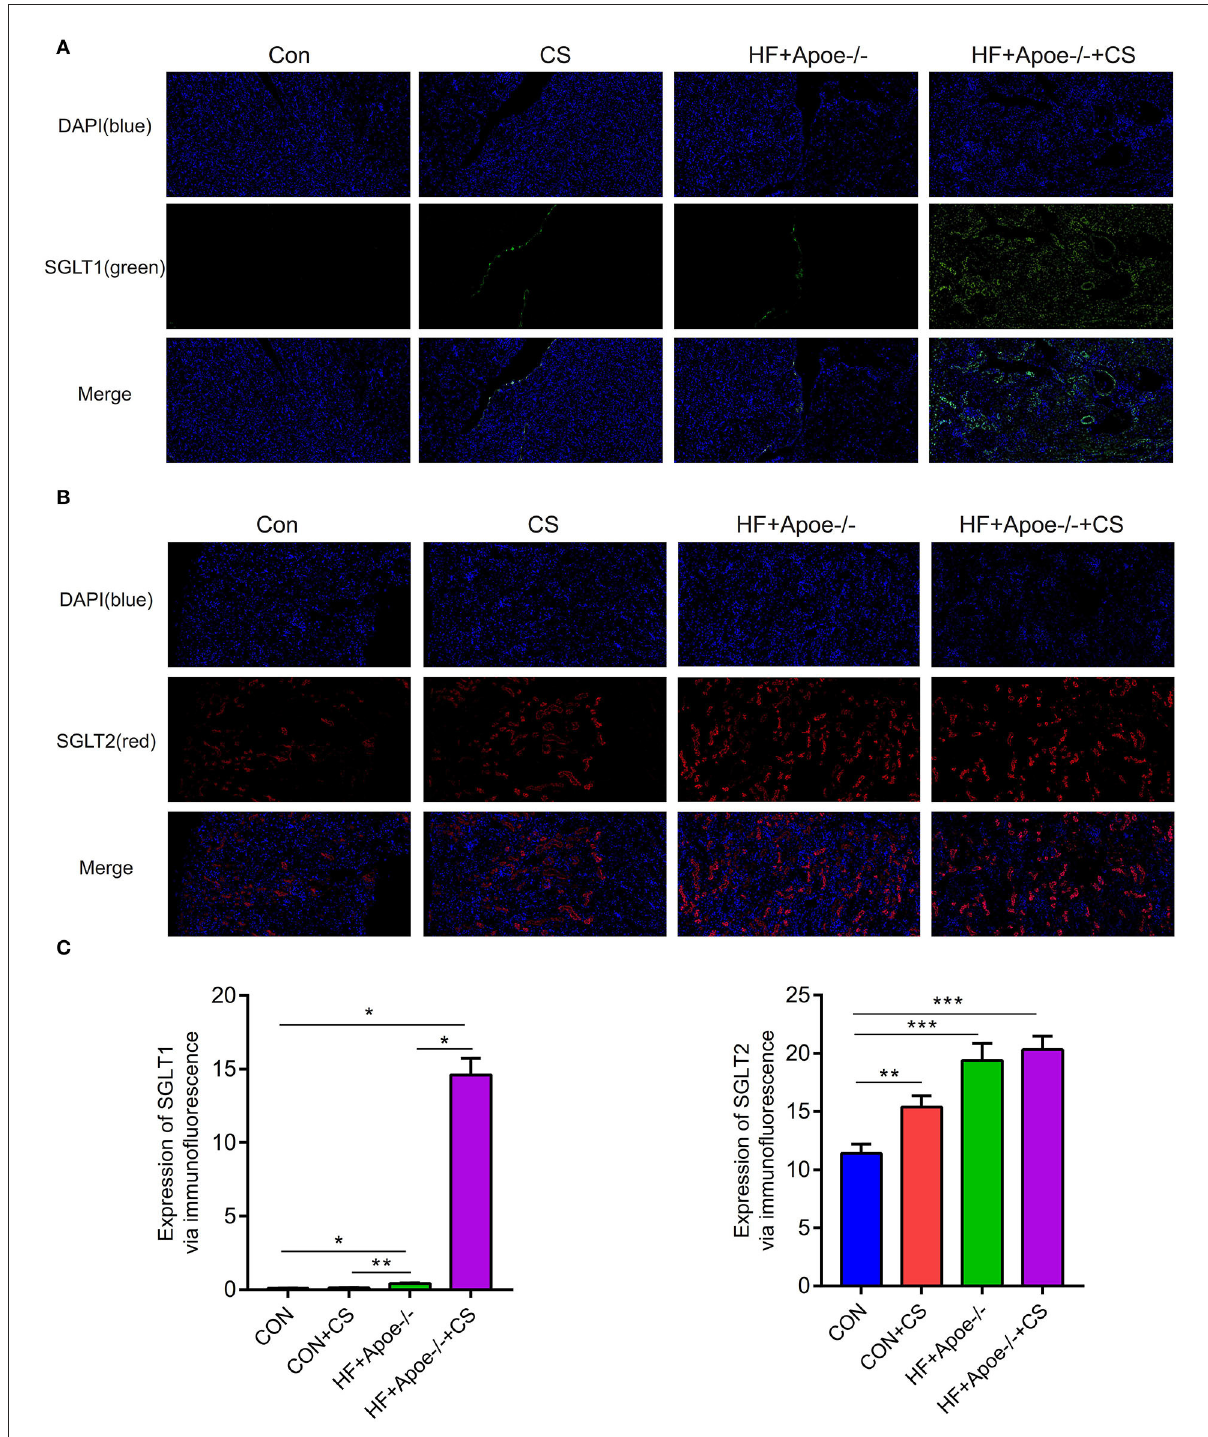
FIGURE5 Upregulated expression of SGLT1 and SGLT2 in the kidney in the HF + Apoe − / − + CS group. (A) In the immunofluorescence assay, SGLT1 stained green. Compared with the CON group, the expression of SGLT1 in the kidney was upregulated in the HF + Apoe − / − and HF + Apoe − / − + CS groups ( P < 0.05). In addition, the expression of SGLT1 in the HF + Apoe − / − + CS group was higher than that in the HF + Apoe − / − group. (B) In the immunofluorescence assay, SGLT2 stained red in the kidney. Compared with the CON group, the expression of SGLT2 in the kidney was upregulated in the HF + Apoe − / − and HF + Apoe − / − + CS groups, and the expression of SGLT2 in the kidney was higher in the CON + CS group than in the CON group. (C) Statistical graph of the expression of SGLT1 and SGLT2 in the kidney. * P < 0.05; ** P < 0.01; *** P <